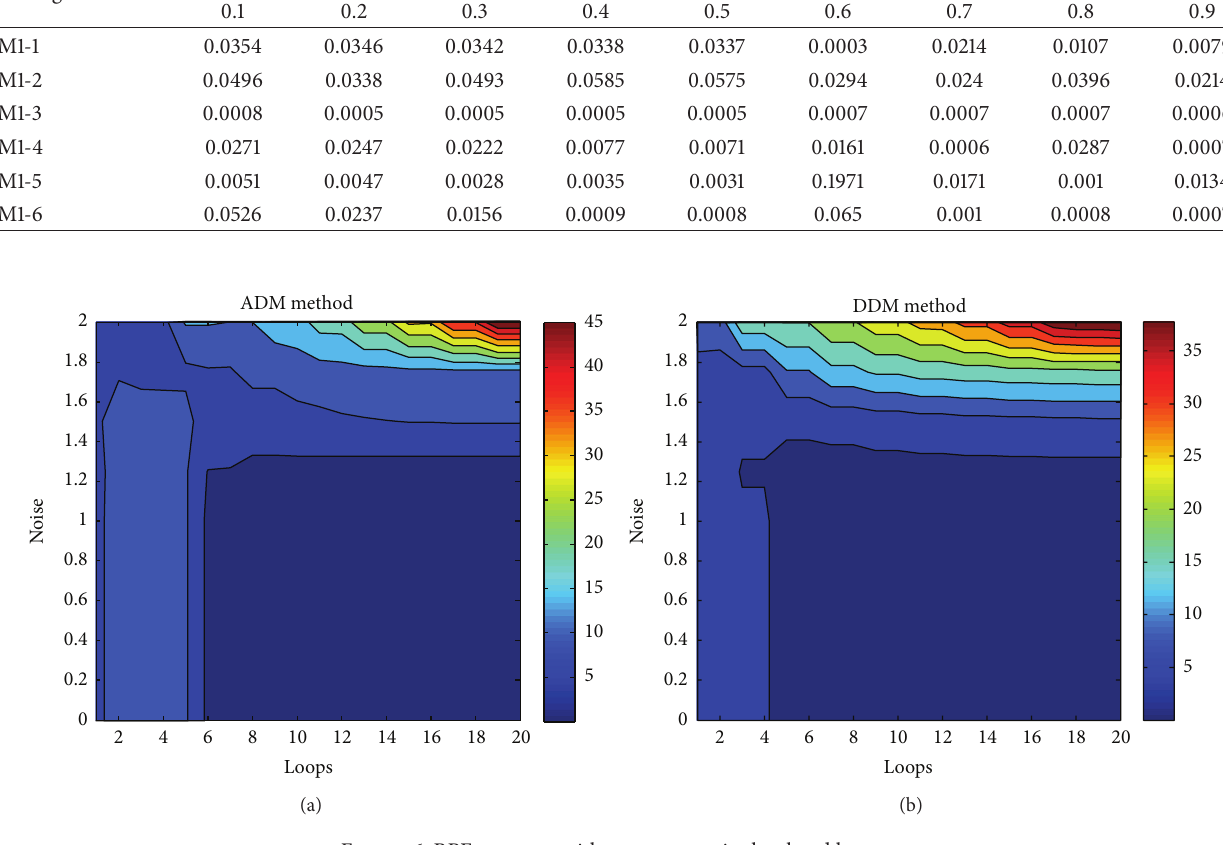
Figure 6: RPE contours with respect to noise level and